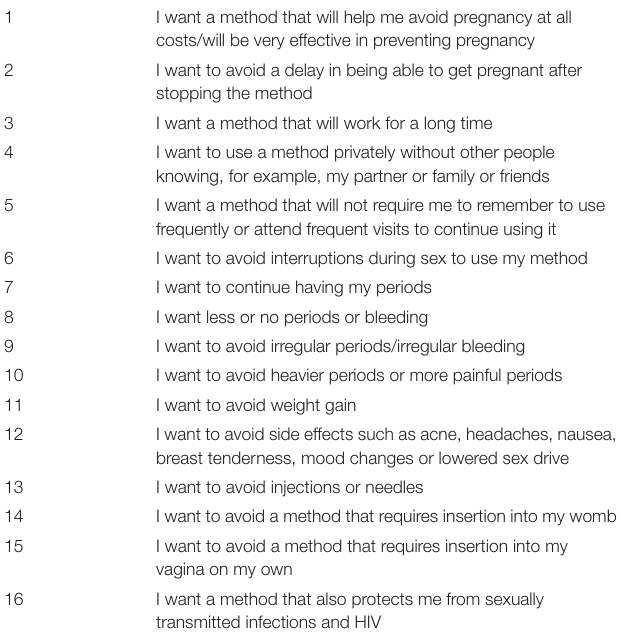
TABLE 1 | Final list of 16 contraceptive attributes used in a contraceptive preference assessment tool in